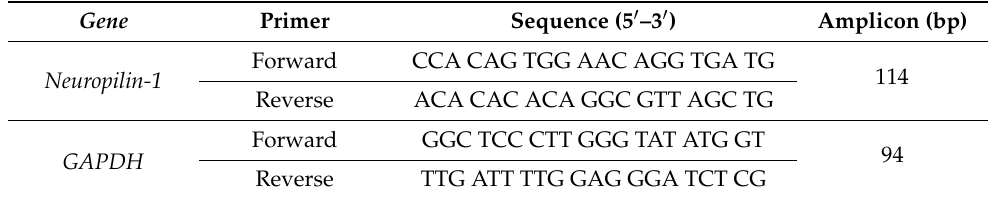
Table 1. Sequences of oligonucleotide primers and product sizes.